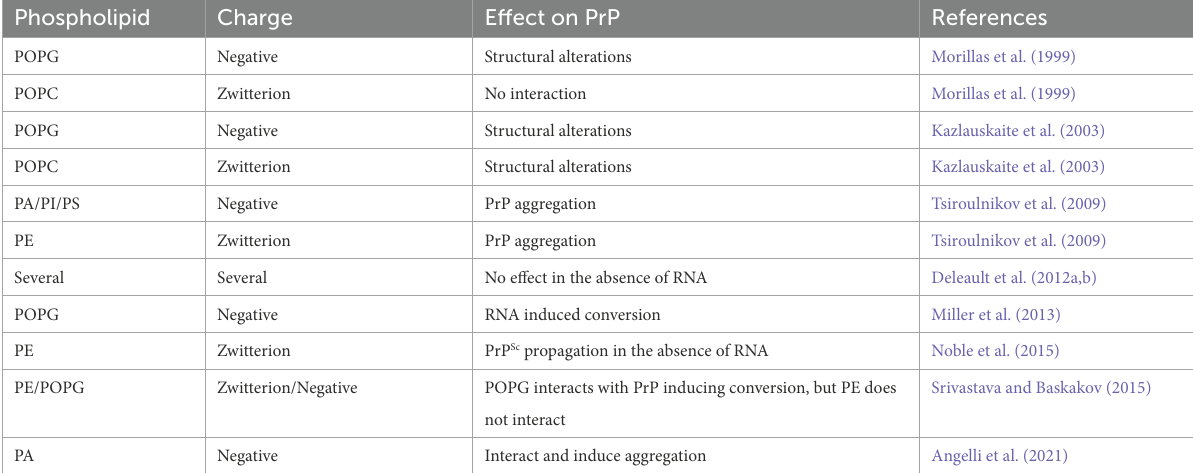
TABLE 1 Described effects of phospholipids with different charges on prion protein (PrP). Phospholipid Charge Effect on